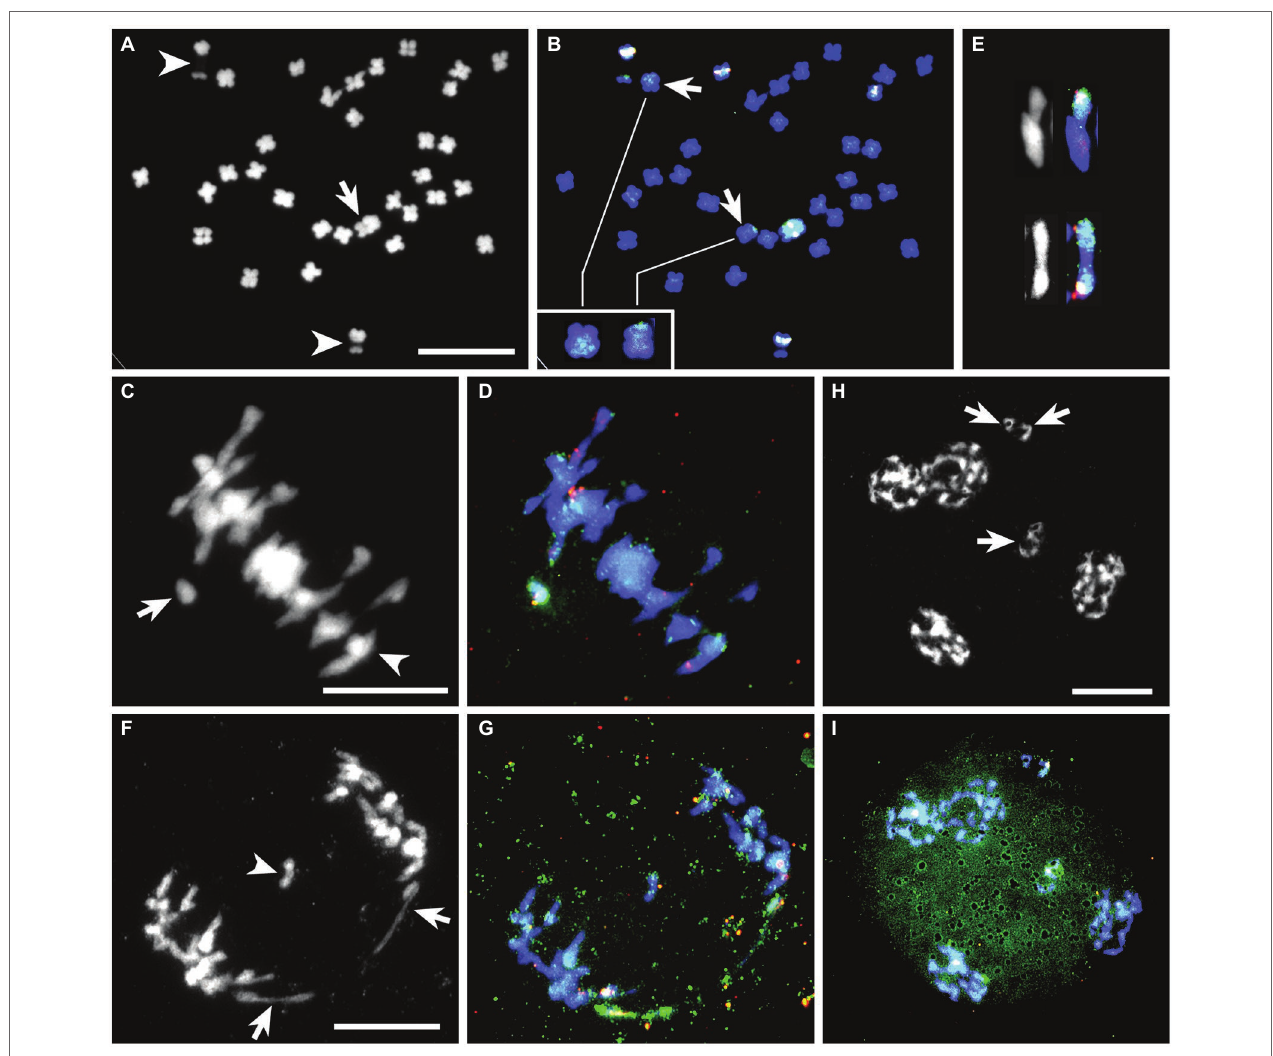
FIGURE 2 | BC 2 -126 sequential FISH-GISH results with 5S rDNA (pink, white) and T. ambiguum genomic DNA (green). (A,B) , A somatic cell (A) DAPI stained (gray scale) and (B) the same cell after FISH-GISH. In (A) , the arrow depicts a single T. ambiguum chromosome, and arrowheads show NOR-chromosomes from T. repens or T. occidentale . In (B) , the arrows show recombinant chromosomes, which are magnified in the inset. (C,D) , A meiotic metaphase I (MI) cell with the same probes as in (A,B) . In (C) , the arrow shows the unpaired T. ambiguum chromosome as a univalent and the arrowhead marks a trivalent involving two recombinant chromosomes and a 5S rDNA-bearing chromosome from T. repens or T. occidentale . (E) , Cut-outs from other MI cells of a trivalent (top) and a bivalent (bottom) involving T. ambiguum or recombinant chromosomes. (F,G) , Anaphase I cell with the same probes as in (A,B) . In (F) , the arrows show the two halves of the T. ambiguum chromosome which has undergone precocious separation of the sister chromatids (PSSC) and the arrowhead marks a laggard chromosome. (H,I) , A telophase II with the same probes as in (A,B) . In (H) , the arrows mark micronuclei with chromosomes likely to be eliminated from the gametes. In (I) , the elimination of the lone T. ambiguum chromosome is shown. Bars 10 μ